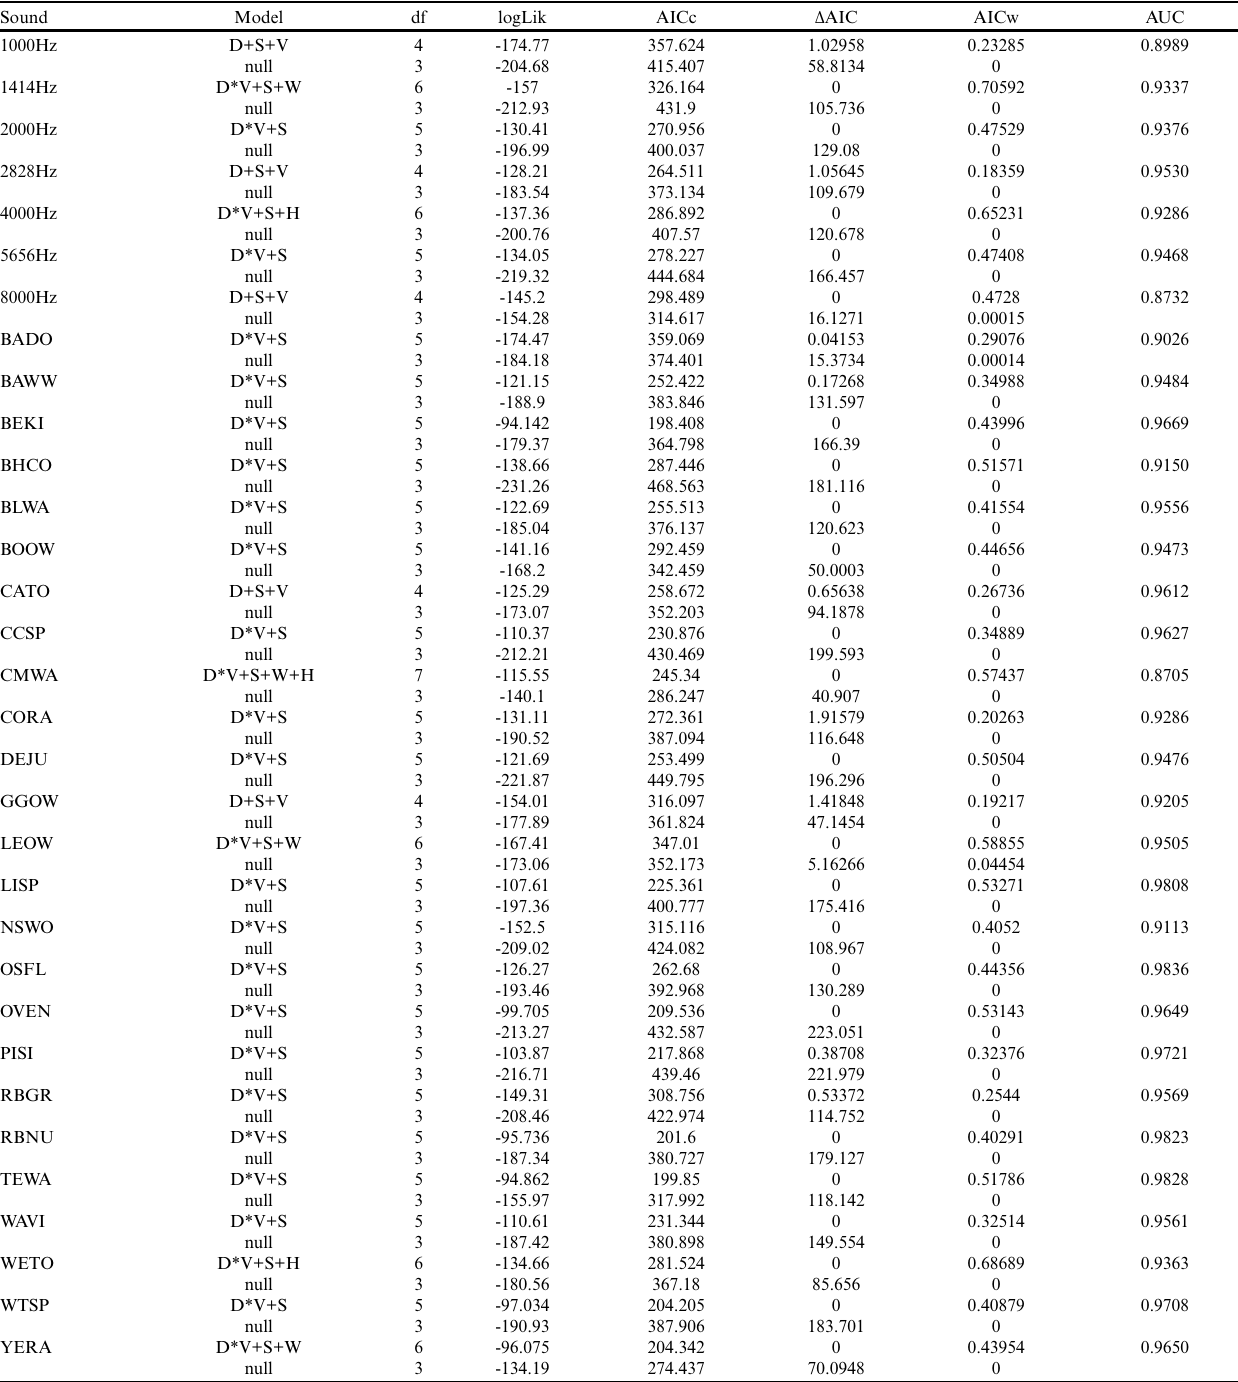
Table 3 . Model selection for factors influencing detection probability of different sounds for the SPL experiment and AUC statistics on test data for the top AIC-ranked model testing differences in detection with varying SPL. All sounds used the same models for selection. We selected top models using lowest AICc value and ∆AICc. For multiple models with ∆AICc < 2, we selected the simplest model with fewest parameters (Arnold 2010). “df” is the degrees of freedom and “logLik” is the log likelihood value for that particular model. “*” indicates variable